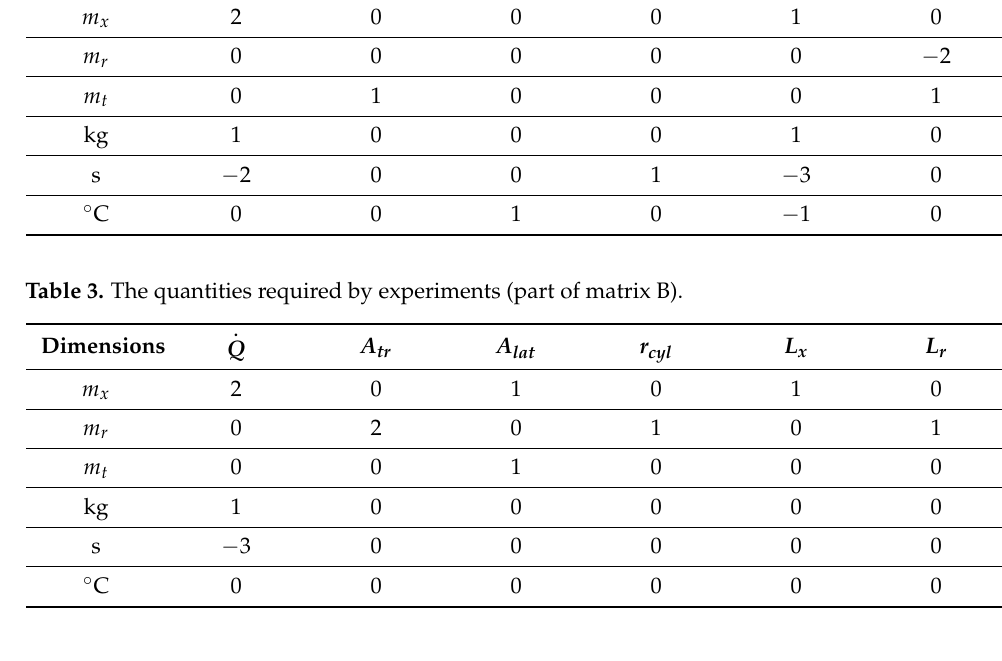
Table 2. Matrix A, comprising independent variables. Dimensions